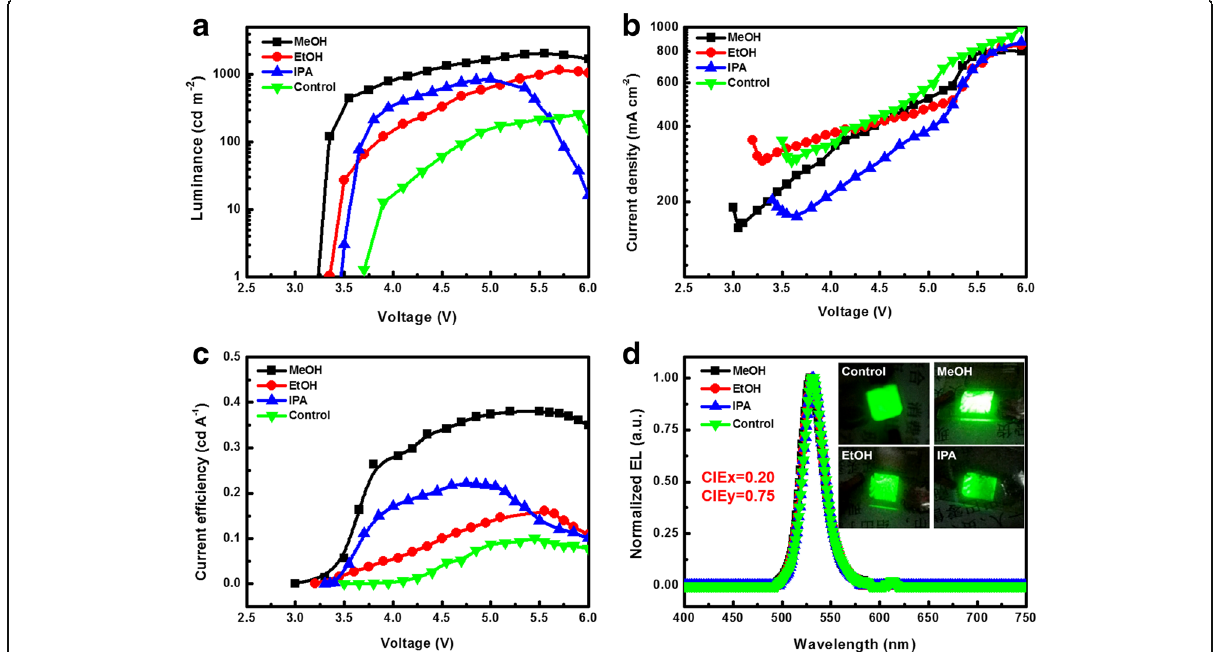
Fig. 2 Device performance of PeLEDs. a Luminance-voltage ( L-V ) curves. b Current density-voltage ( J-V ) curves. c Current efficiency-voltage ( CE-V ) curves. d Normalized EL spectra and photographs of PeLEDs